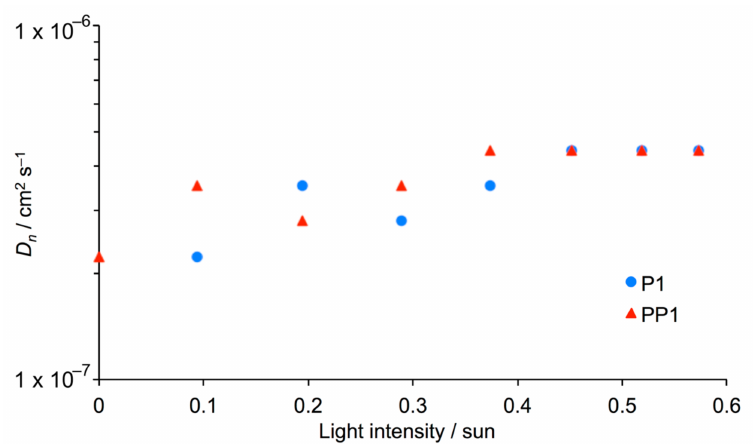
Figure 11. Chemical diffusion coefficients for DSCs with P1 or PP1 at different light intensities.